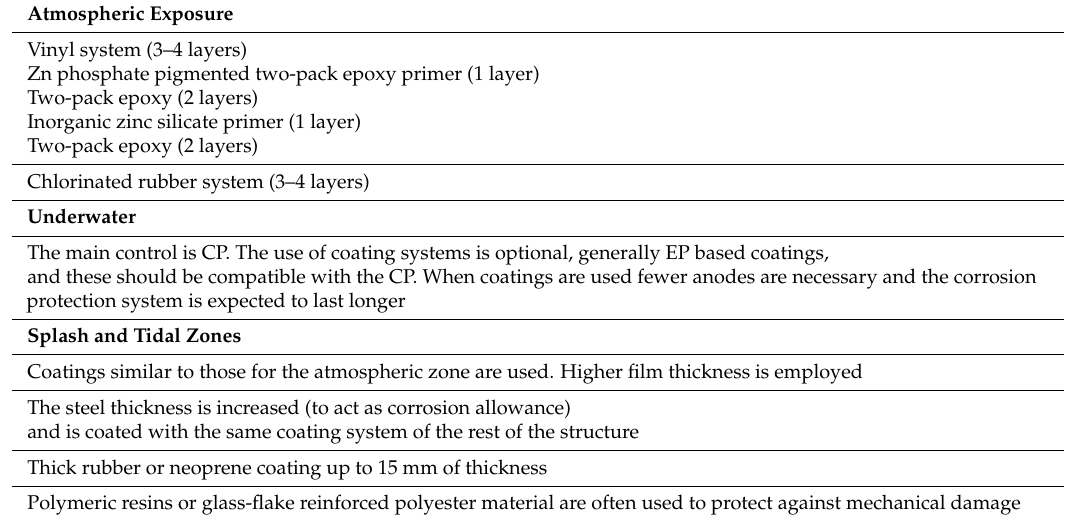
Table 7. Type of coating systems typically used according to exposure zone of